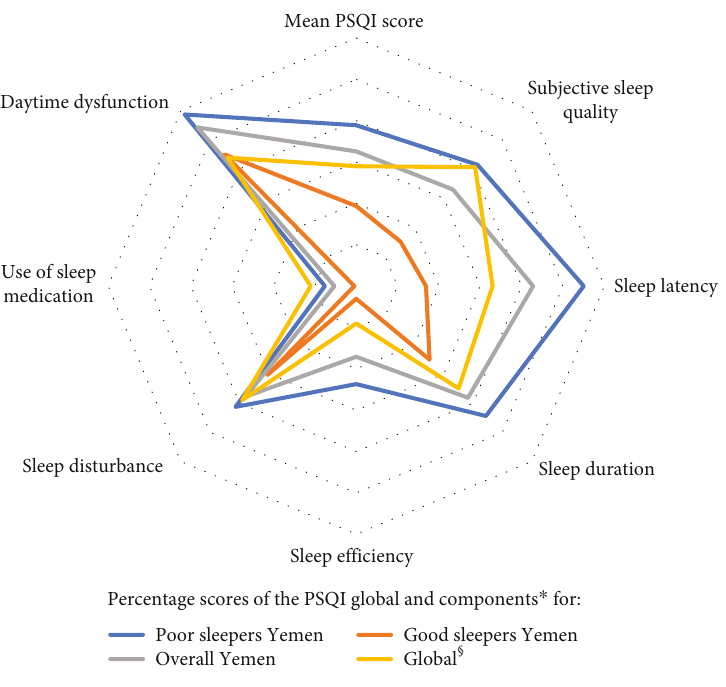
Figure 2: Sleep quality and patterns among medical students in Yemen and at a global level. ∗ Source data of the PSQI global and components ’ scores are included in supplemental File 2. § Source: Rao et al. “ Sleep Quality in Medical Students: a Comprehensive Meta-Analysis of Observational Studies. ” Sleep Breath . 2020; 24(3): daily dysfunction score ð 1 : 63/3 Þ ∗ 100 = 54 : 3 ).